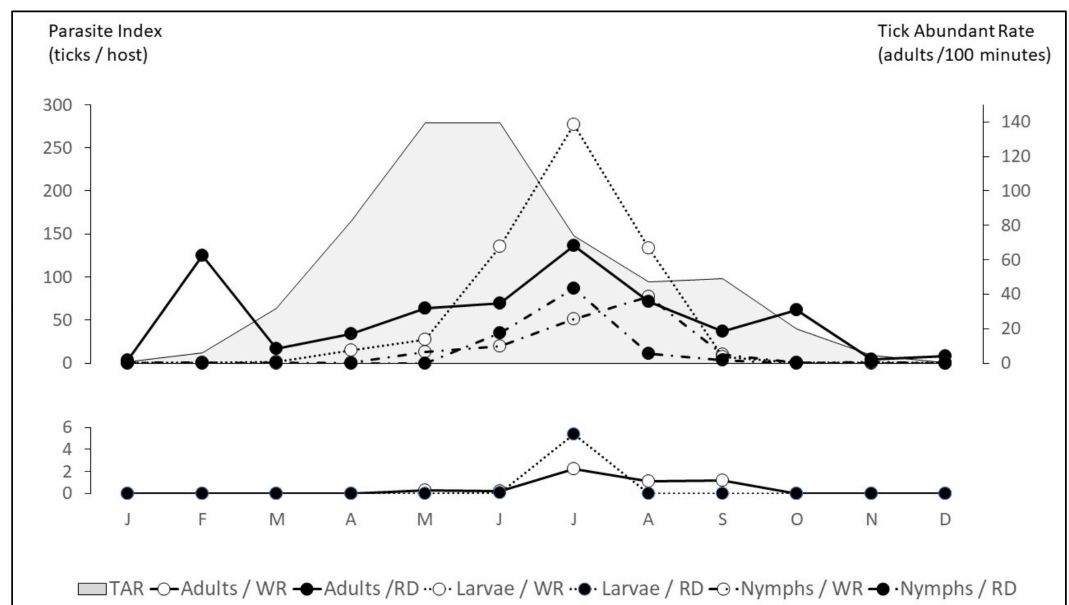
Figure 3. Seasonal pattern of main host infestation by Hyalomma lusitanicum and Tick Abundance Rate (host seeking adults) in a meso-Mediterranean area [32,35,36]. RD = red deer, WR = wild rabbit. Table 4. Seasonal pattern of Hyalomma lusitanicum and Hyalomma marginatum . * Estimated by dragging. Hyalomma lusitanicum Hyalomma marginatum Adult Host Seeking * Complete annual pattern is